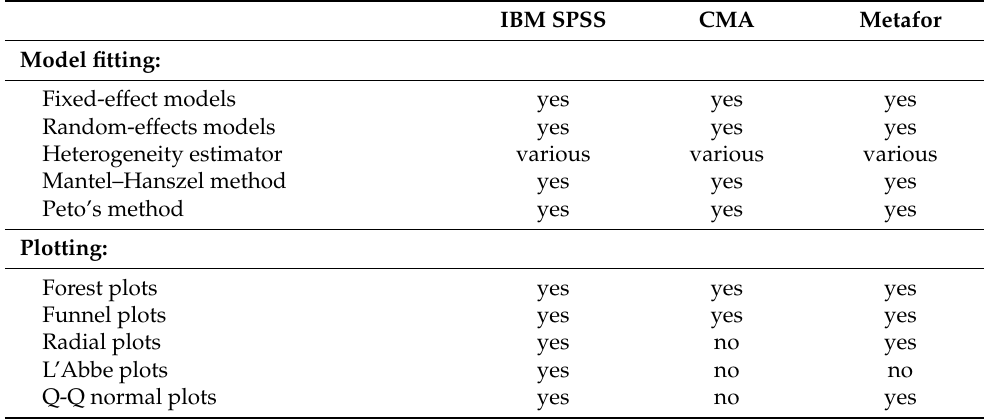
Table 5. Comparison of the Capabilities of the IBM SPSS, CMA, and Metafor Packages for Conducting